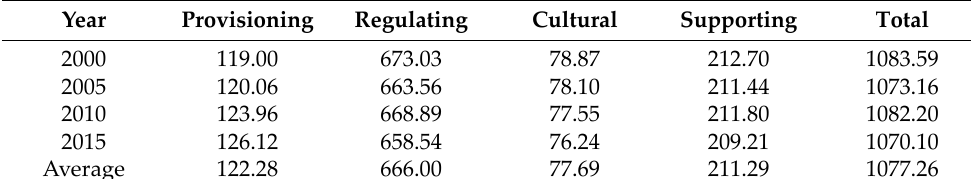
Table 7. ESV of the Manas River Basin from 2000 to 2015 (10 8 ¥).